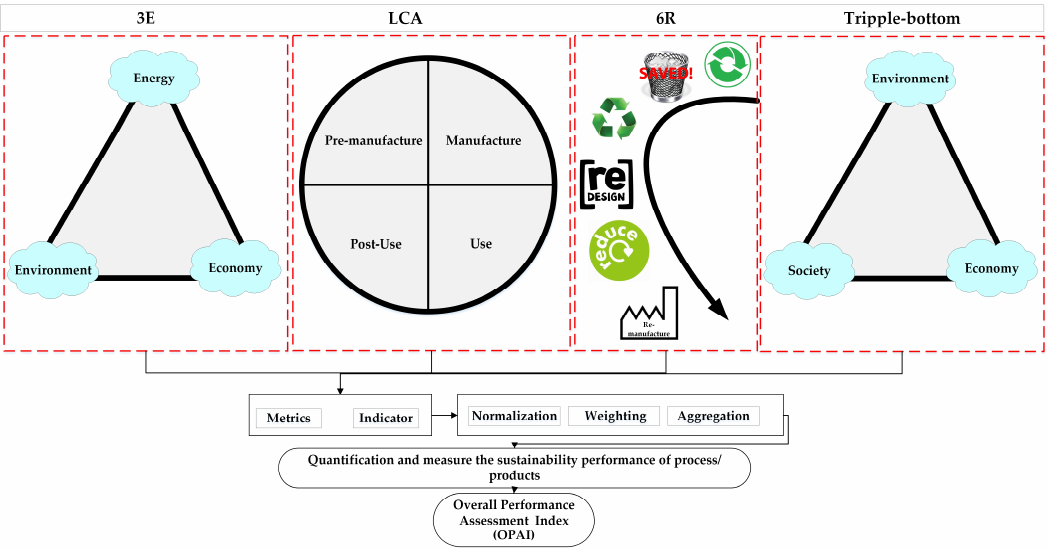
Figure 2. Methodology for the quantification of sustainability values of the process.